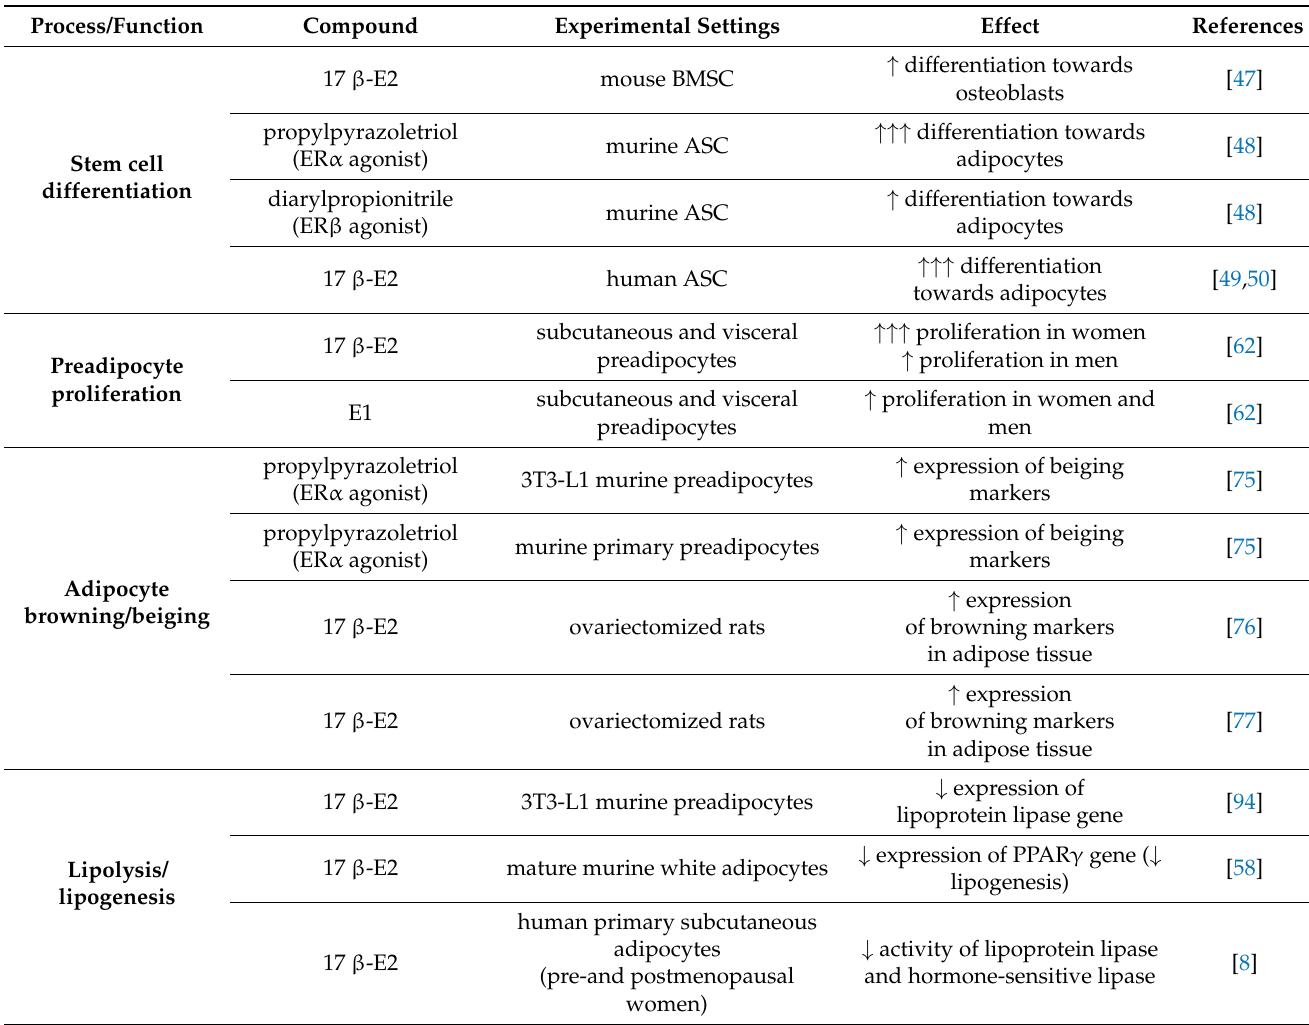
Table 1. Role of estrogens in the regulation of adipogenesis and adipose tissue activity. Process/Function Compound Experimental Settings